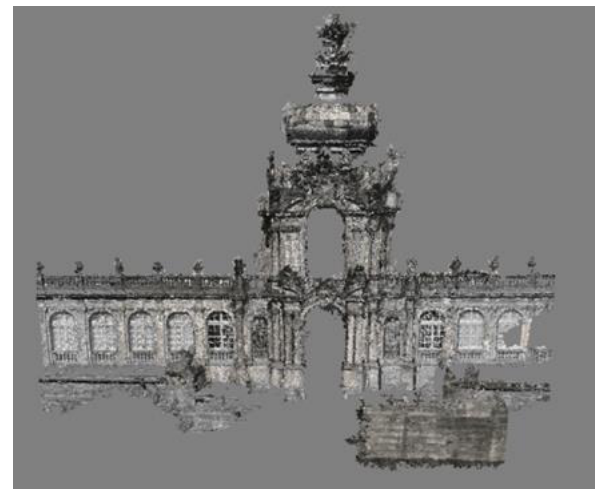
Figure 3. Point cloud generated from historical images (exterior view of the Zwinger)